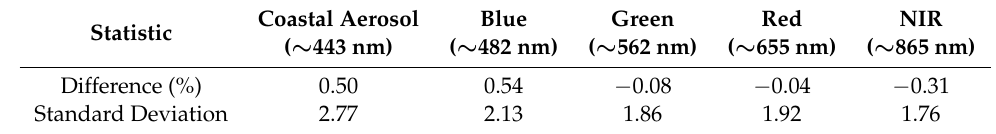
Table 6. Cross-calibration combined difference statistics